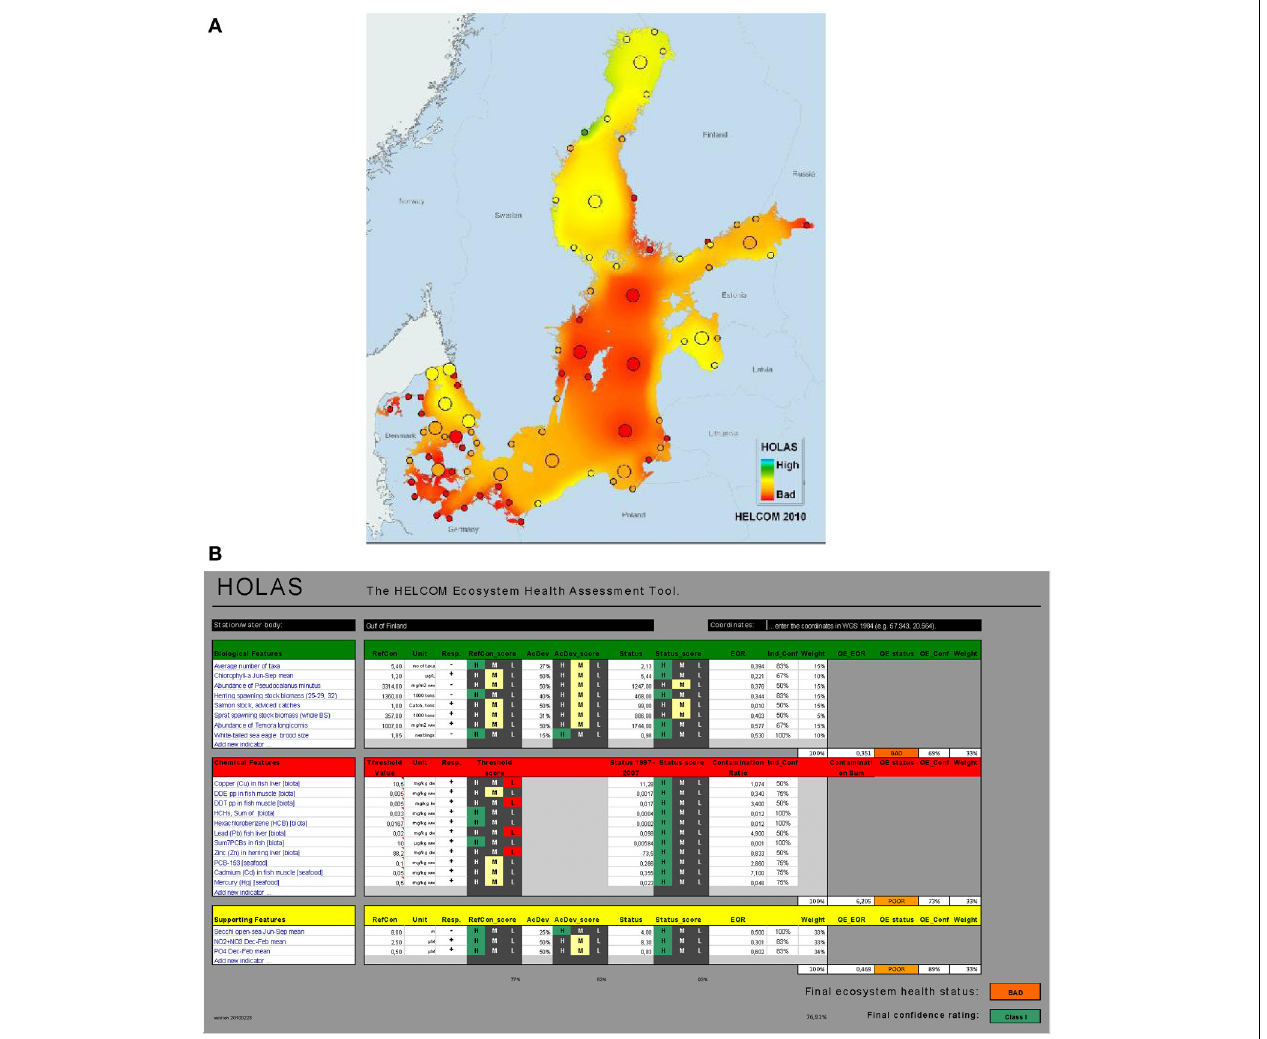
FIGURE 1 | (A) Example of an integrated assessment of ecosystem health in the Baltic Sea 2003–2007 based on the HOLAS tool. (B) Screenshot to illustrate how the HOLAS classification tool for the Gulf of Finland works. See HELCOM (2010) for details. Courtesy by Helsinki Commission.